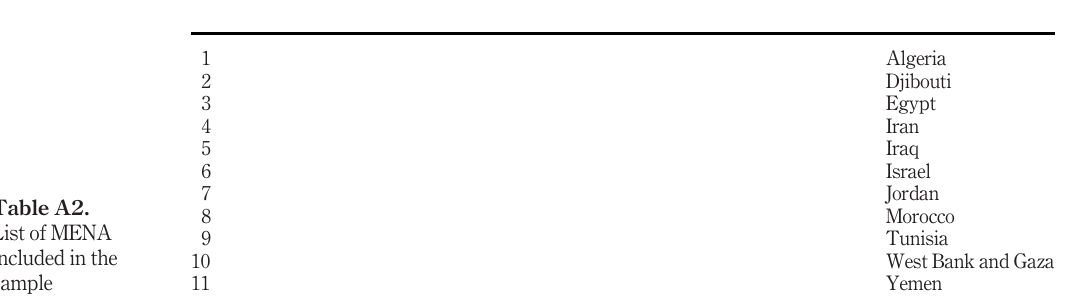
Table A1. List of EMs included in the sample